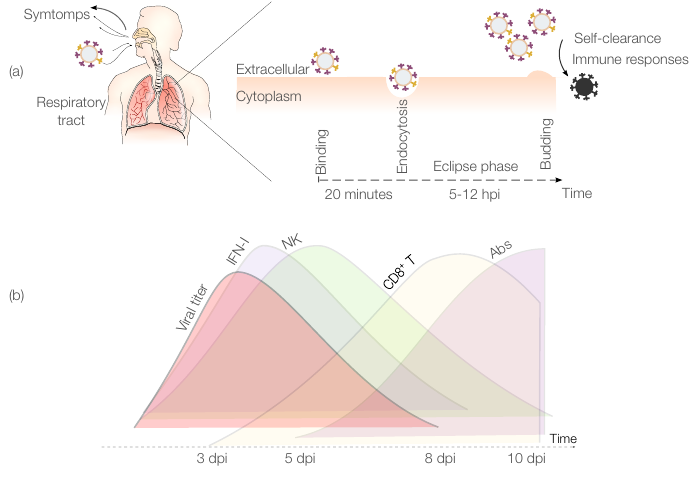
Figure 1. Influenza A virus (IAV) infection and dynamics. ( a ) Description of the main phases of IAV infection within a host. After entering the respiratory tract, each virion binds to a target cell. Then, virions enter the eclipse phase (5–12 hpi), before starting to replicate and infecting other cells; ( b ) IAV and immune response (IR) dynamics. The innate IR is mainly represented by interferon (IFN)-I and by natural killer (NK) cells, whereas the adaptive IR is mainly driven by cytotoxic CD8 + T cells (CTLs) and antibodies (Abs). Days post infection is abbreviated with